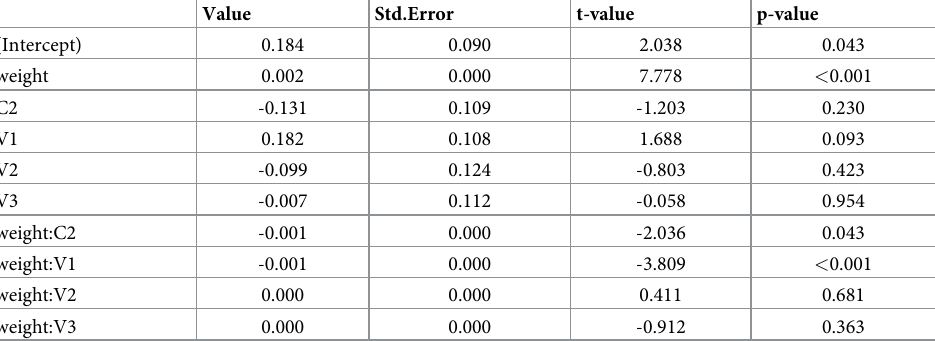
Table 3. Coefficients of the generalized least square analysis of the PHA-index dependent on chick weight. The table shows the estimated value, the standard error, the t-value and the significance (p-value) of the terms. The rows represent the groups, the weight and their interactions. Values indicate the differences to the reference value (inter- cept), which represents pha-index from the control group C1. Value Std.Error t-value p-value